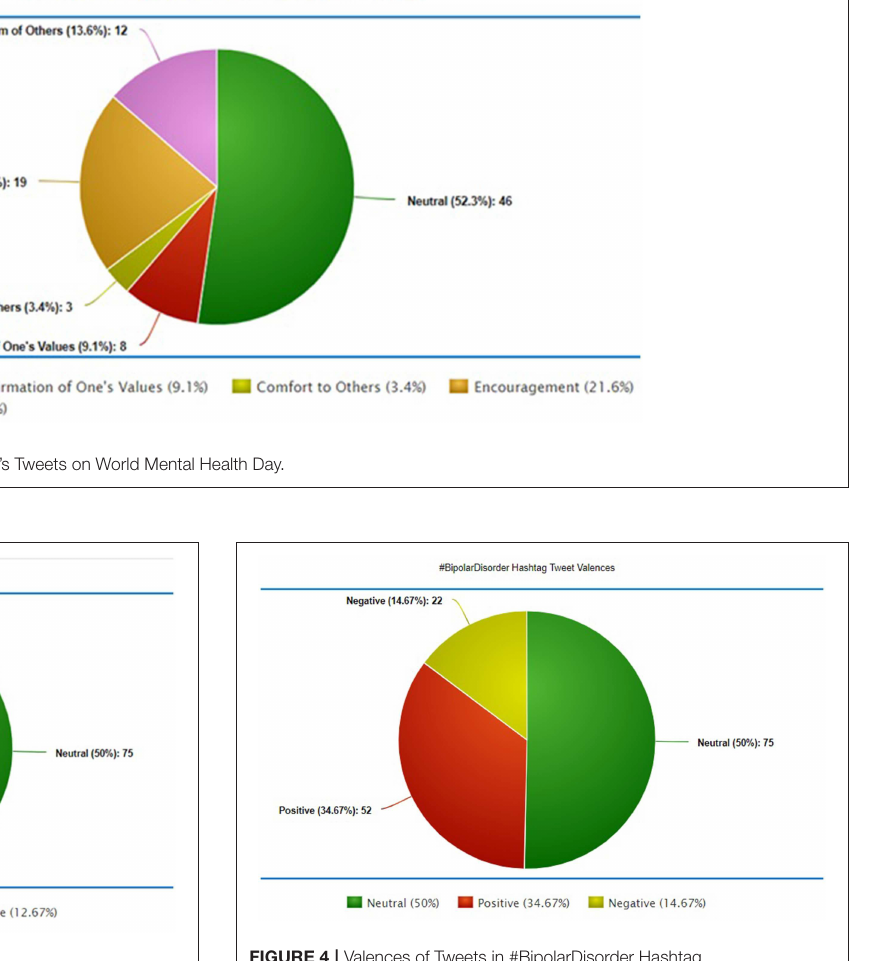
FIGURE 3 | Valences of Tweets in #Bipolar Hashtag.